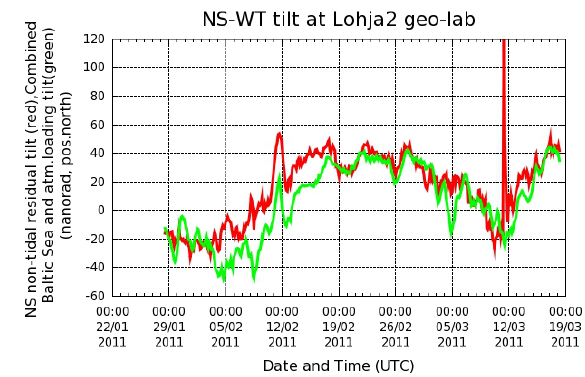
Figure 5: NSWT non-tidal residual tilt (red) is compared with the combined atmospheric loading NS-model tilt and the Baltic Sea loading tilt (green). At right side, there is a strong tilt resid- ual caused by a magnitude 9.0 Tohoku-Oki earthquake in Japan 11.03.2011.